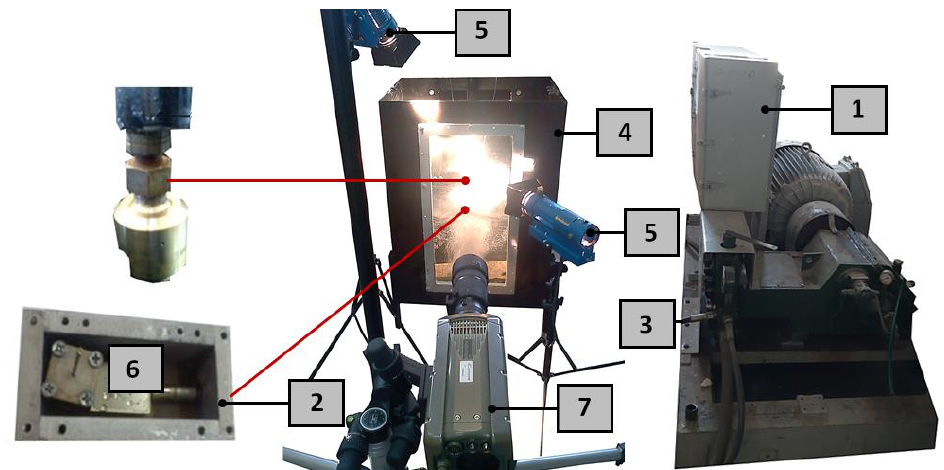
Figure 10. Measuring station for testing the water stream produced in a self-excited pulse head working in an aqueous medium: 1−P30 monitor, 2−force sensor mounting, 3−high-pressure hose, 4−water tank, 5−illuminator, 6−force sensor with a KISTLER 9602AQ01 transducer, 7−Phantom V12.1 camera.